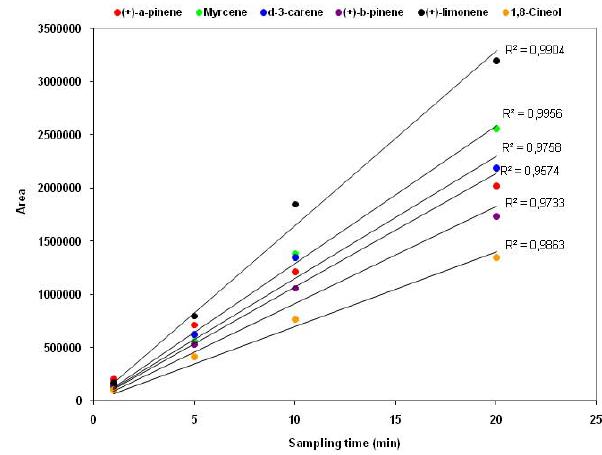
Fig. 6. Extraction kinetics of monoterpenes in 1, 5, 10 and 20 min sampling times and correlation coefficients using